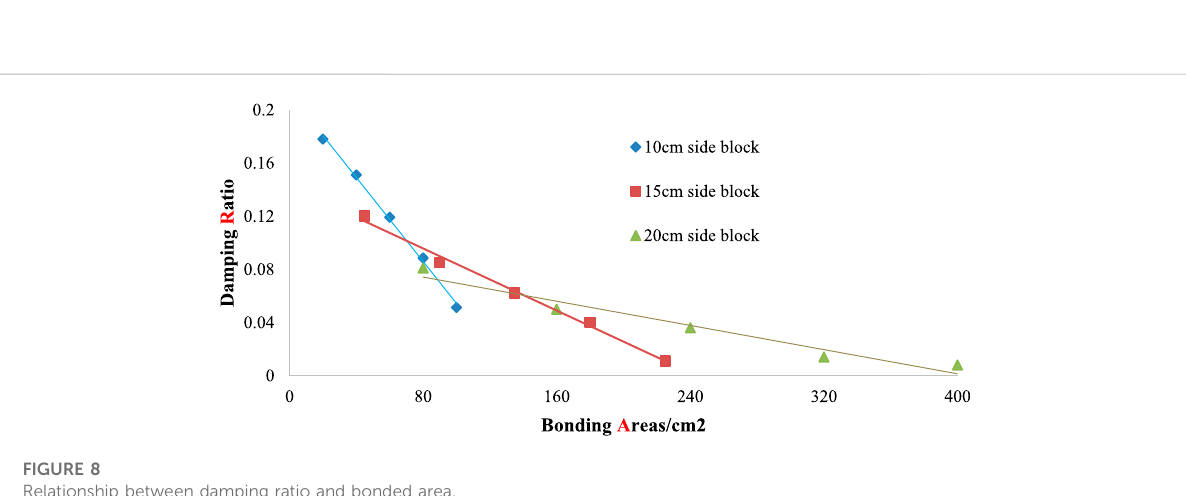
FIGURE 8 Relationship between damping ratio and bonded